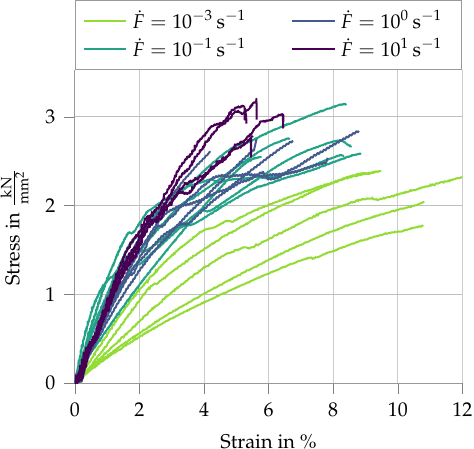
Figure 1. Results of PE fiber tension tests at different strain rates; data from